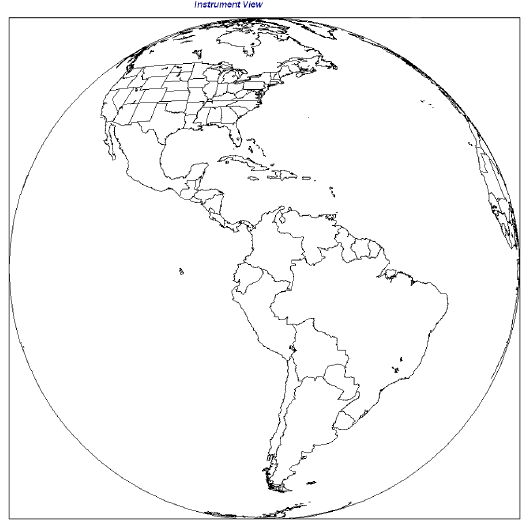
Figure 2. Model spatial area